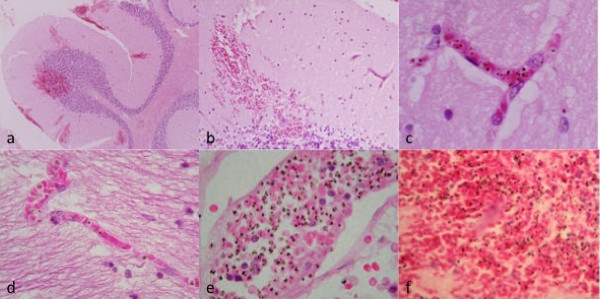
Haematoxylin and eosin stained sections of the cerebellum (a, b, c, e, f) and cerebrum (d). Low power view showing haemorrhages in the grey and white matter × 20 (4a). Haemorrhage in the cerebellar molecular layer × 40 (4b). 4c × 400 and 4d both × 200 show capillaries with sequestered parasitized red blood cells. There was no perivascular inflammation nor intravascular thrombosis. Venule with parasitized red blood cells × 200 (4e) and haemorrhage showing mixture of parasitized and non-parasitized red blood cells × 400 (4f).